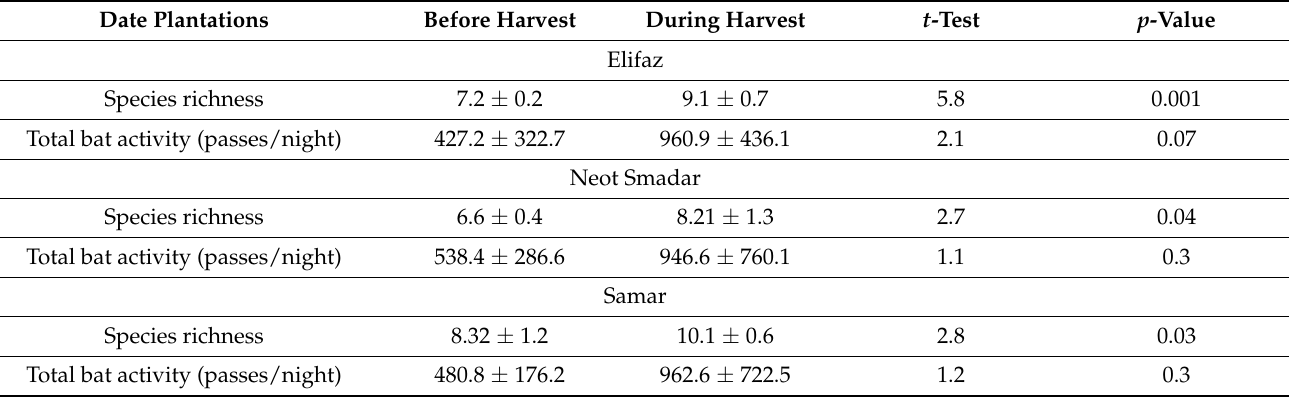
Figure 2. Bat species richness ( A ) and bat activity rates ( B ) before date harvesting, and bat species richness ( C ) and bat activity rates ( D ) during date harvesting. Recordings were made with bat detectors in the three date plantations of Elifaz (conventional), Neot Smadar (organic no ground cover), Samar (organic with intensive ground cover) in June 2018 before harvest time (63 nights) and in September 2018 during harvest time (66 nights) of the dates. Results are presented as average ± S.D. Asterisk indicates significant differences. Table 2. Average species richness and total bat activity ± SD before and during the harvest of the dates in three date plantations in the Arava valley, Israel. Neot Smadar and Samar are organic plantations, while Elifaz is a conventional date